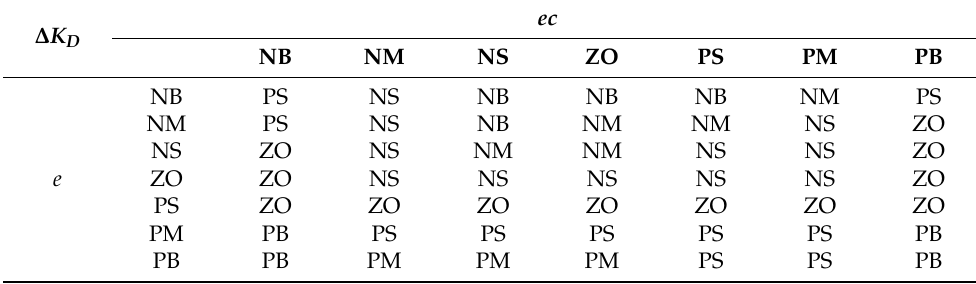
Table 3. ∆ K D fuzzy control